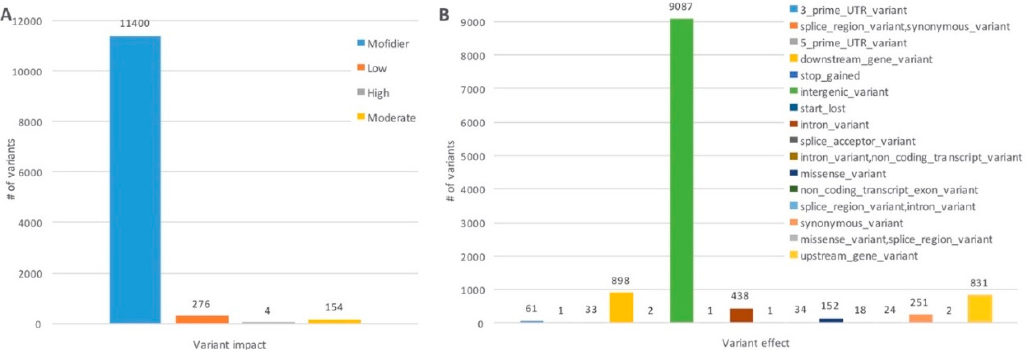
Figure 3. Variant effect predictor output for the 11,834 SNPs used in subsequent analysis. ( A ) Variant impact. ( B ) Variant consequences, according to genome site location.